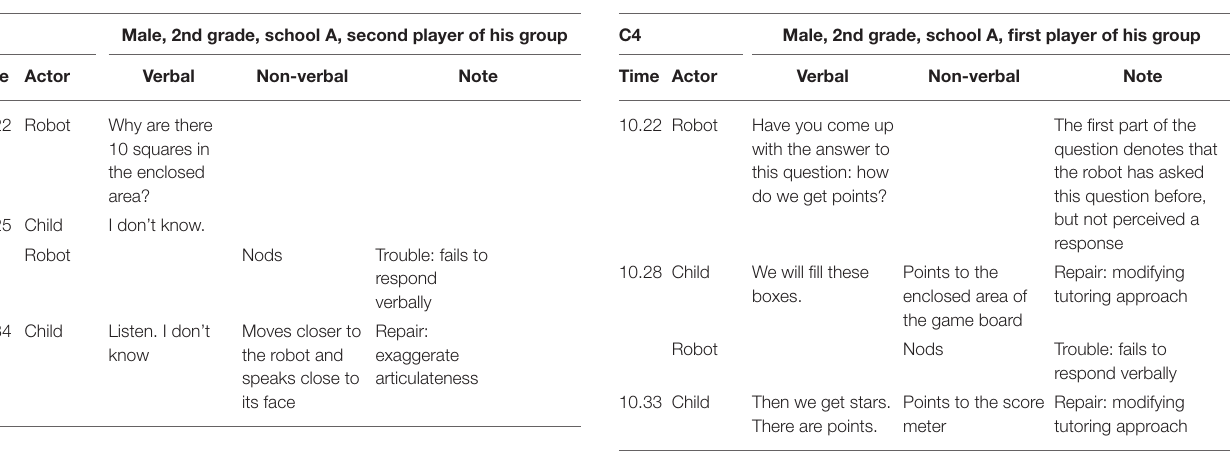
TABLE 3 | Excerpt for C2. TABLE 4 | Excerpt for